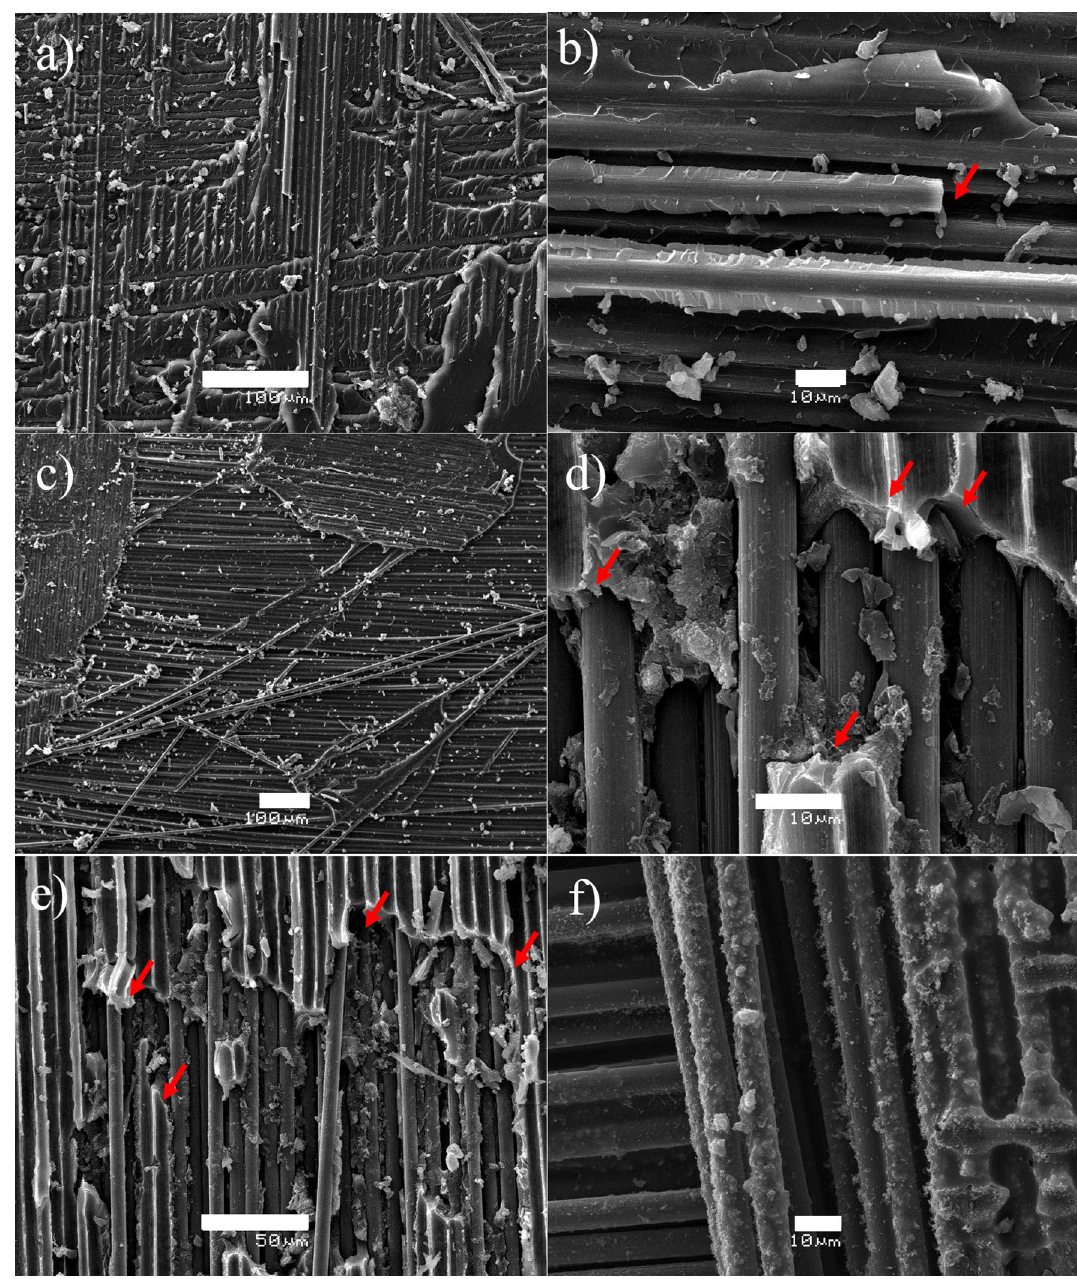
Figure 7. SEM images of the fracture zone of the specimens made with VCFs ( a , b ); fibers with good adhesion are observed. The fracture zone of the specimens manufactured with RCFs-500 °C ( c , d ); zones with a poor interface zone are observed. The fracture zone of RCFs-500 °C-CNTs ( e , f ); CNTs adhered to the fiber and matrix are